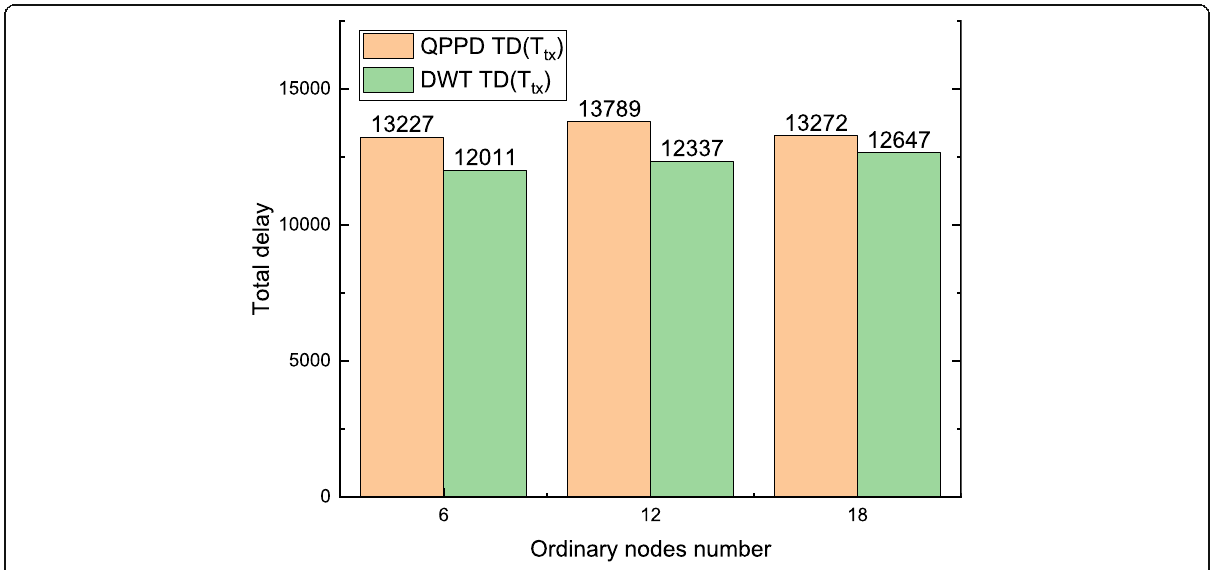
Fig. 45 The total volume of data randomly changes from 0 to 3; the total